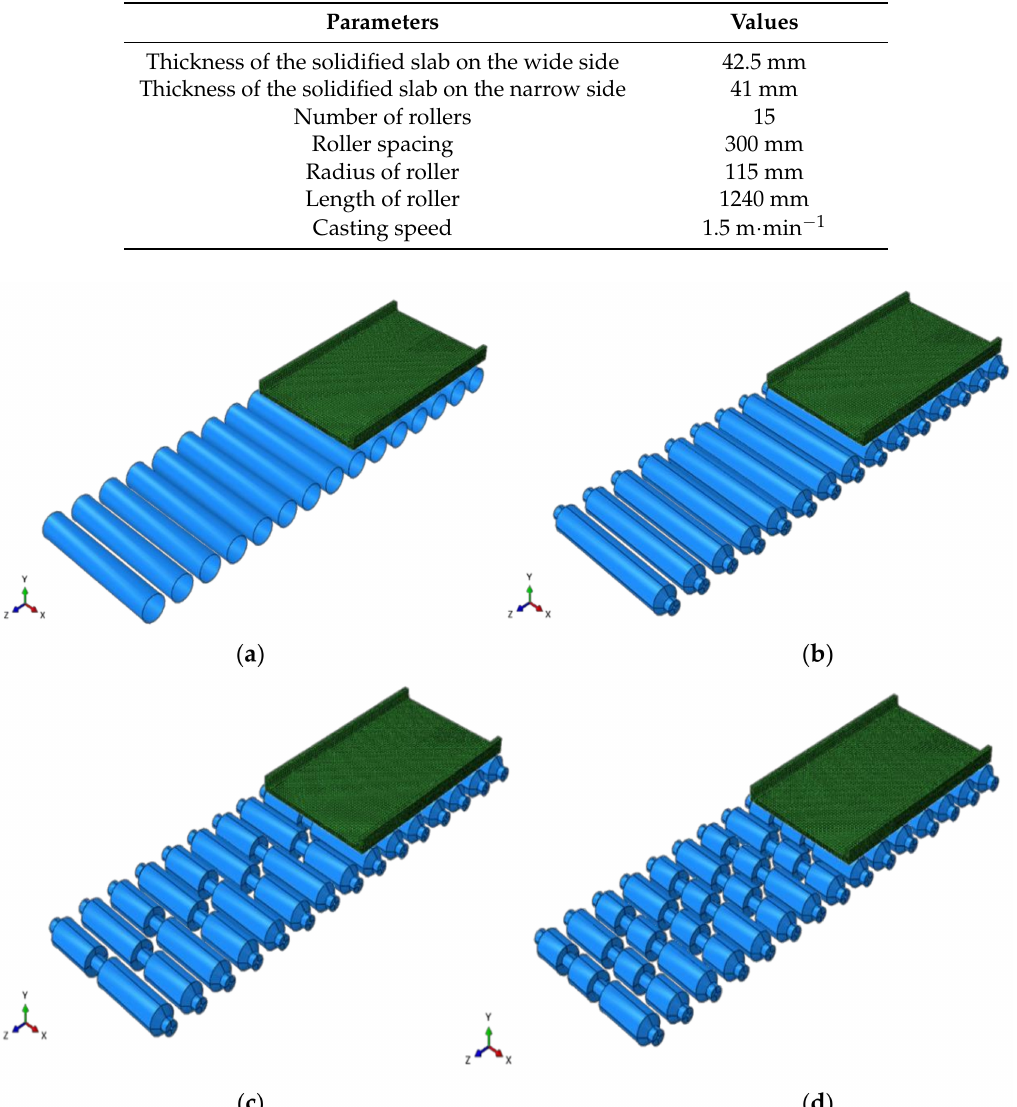
Figure 6. ( a ) Bulging model with rigid solid rollers. ( b ) Bulging model with elastic solid rollers. ( c ) Bulging model with two-segment rollers. ( d ) Bulging model with three-segment